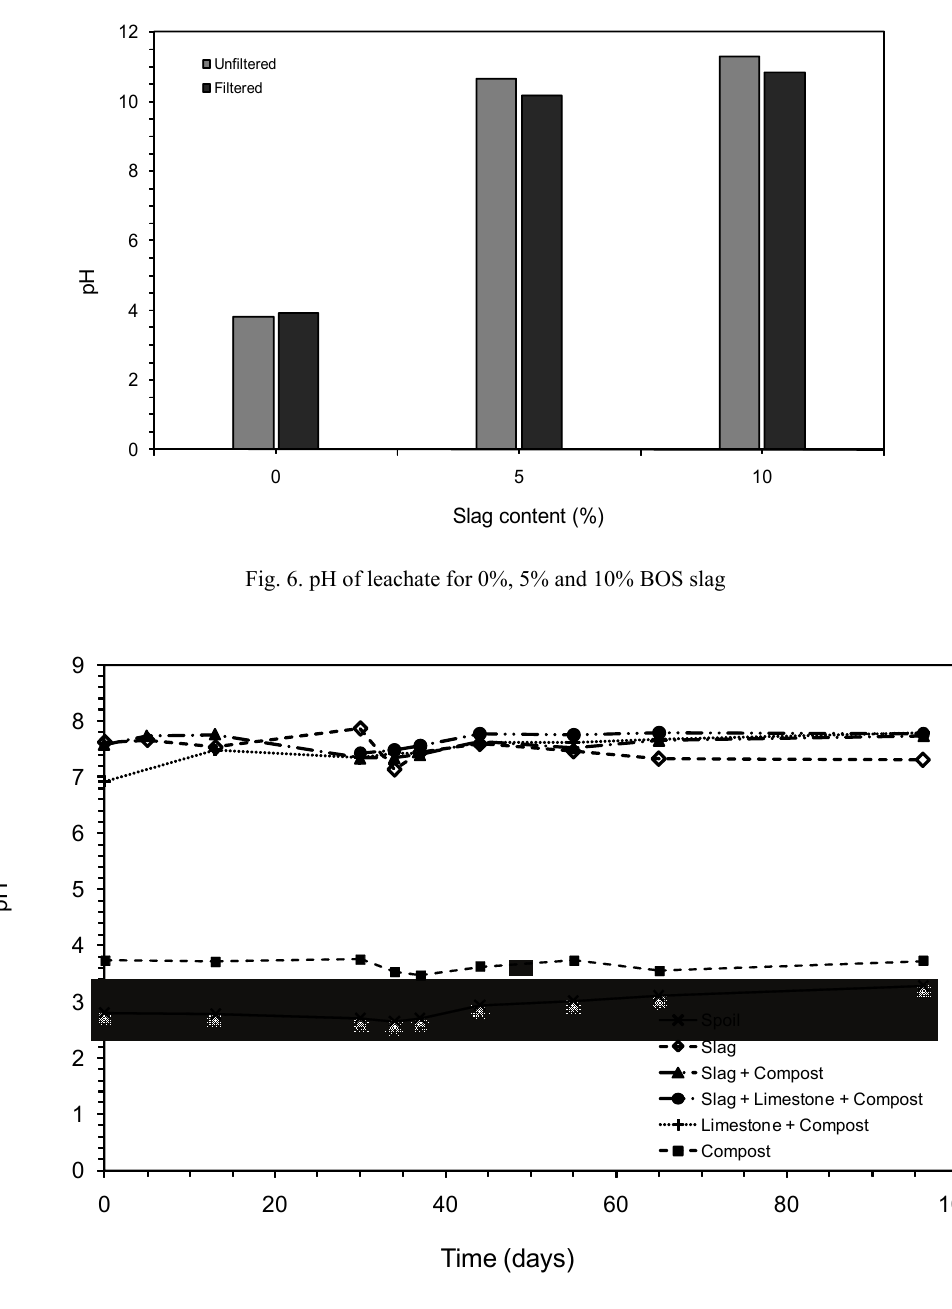
Fig. 7. Results of pH testing in laboratory trials on Car Wood spoil (slag, compost and limestone were added at up to 5% by dry weight of